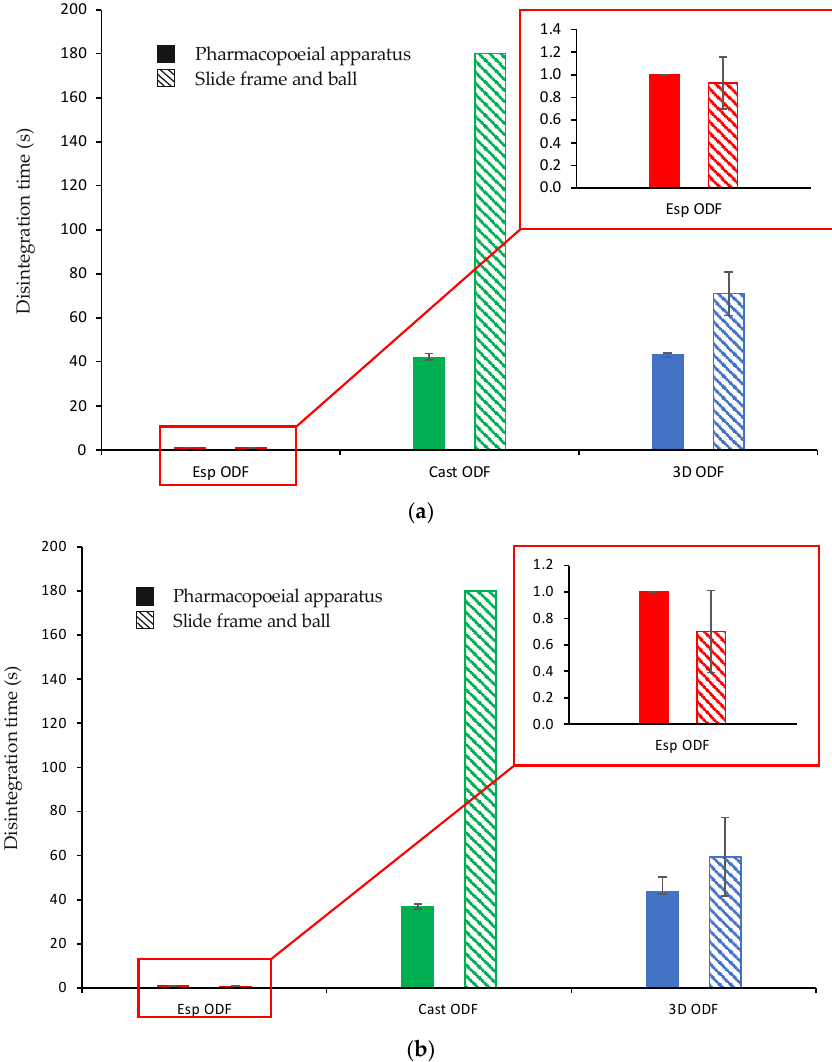
Figure 6. Disintegration time of ODFs ( n = 6) (( a ) after preparation; ( b ) after one month storage at 25 °C and 60% RH.